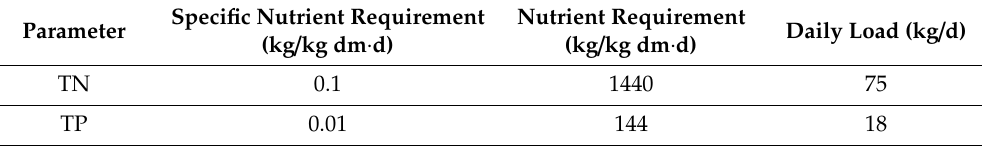
Table 9. Nutrient requirements in the microalgal